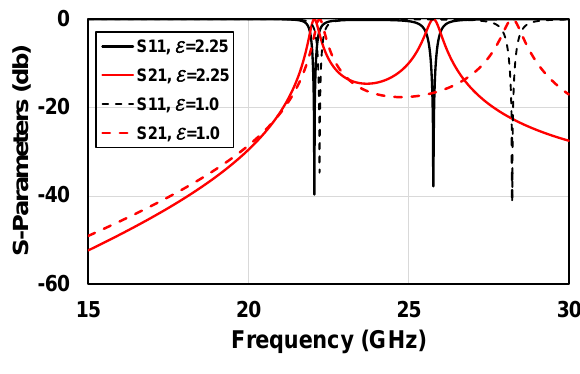
Fig.4. Effect of permittivity on S-parameter